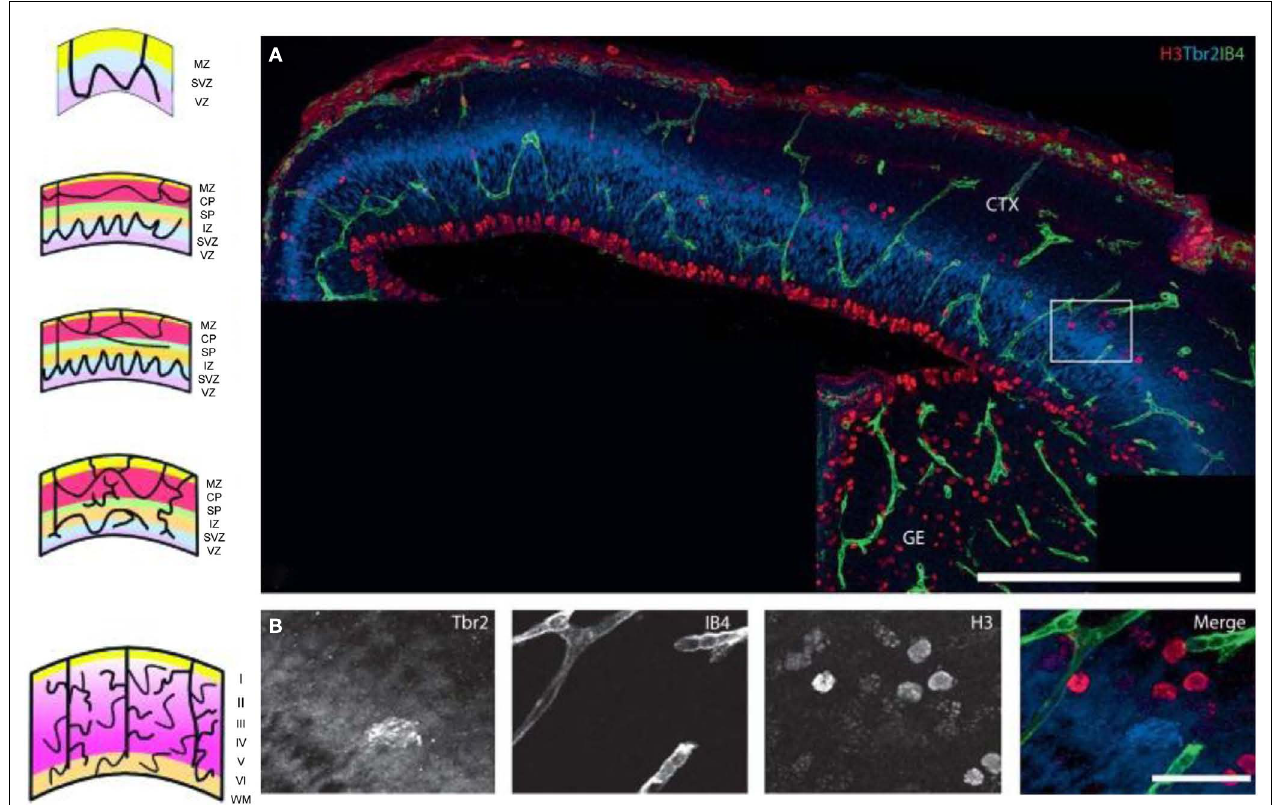
many small parenchymal arteries is present. MZ, marginal zone; SP, subplate; I–VI represent cortical layers in adult. (A) Association of SVZ blood vessels to mitotic profiles in developing cerebral cortex and ganglionic eminence in an E14 brain. Blood vessels (revealed with IB4-green) and the mitotic profiles (revealed with pH3-red immunoreactivity) on a low power image of a sagittal section through the cortex. Scale bar = 400 μ m. CTX = Cerebral cortex. (B) Higher magnification of the area indicated by the rectangle in A, illustrate examples of dividing intermediate progenitor cells (pH3 + Tbr2 + ) that are in close proximity to the cortical vascular plexi (IB4 + ). Scale bar = 50 μ m. Modified from Stubbs et al. (2009) and Nie et al.